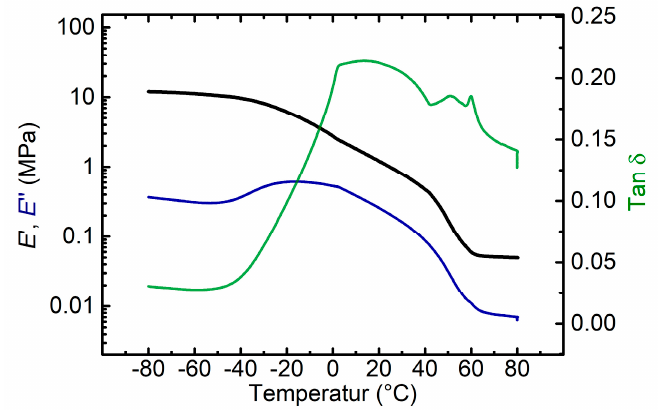
Figure 5. Evolution of storage modulus E ′ (black color), loss modulus E ″ (blue color) and tan δ (green color) as a function of temperature for the PEUU foam.